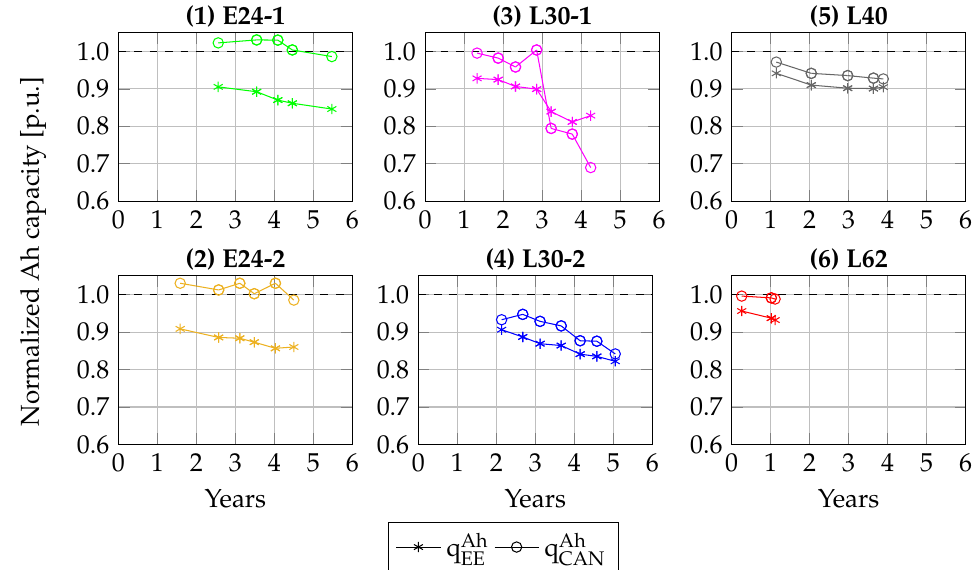
Figure 6. Normalized Ah capacity comparison between the measured EE (represented by asterisks) and CAN-bus readings (represented by circles).